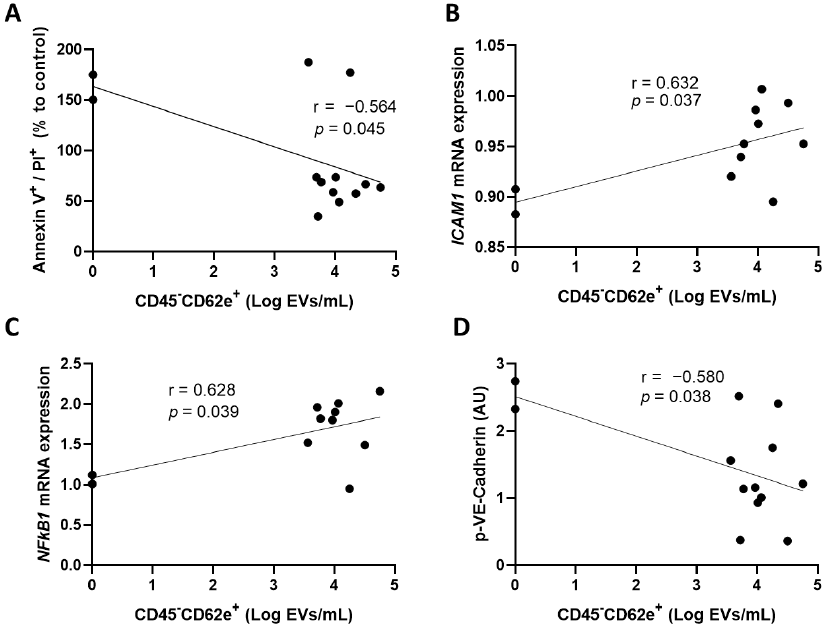
Figure 2. Circulating CD45 - CD62e + extracellular vesicles and endothelial cell activation. The correlation between CD45 - CD62e + EVs and ( A ) endothelial cells undergoing late apoptosis and necrosis, ( B ) endothelial cell ICAM1 mRNA expression, ( C ) endothelial cell NFκB1 mRNA expression; ( C ) and ( D ) phosphorylated VE-Cadherin protein expression was assessed. Data are represented as a relative percentage to cells treated with control, uninfected plasma. Significance was determined by Pearson correlation. p ≤ 0.05 was considered significant. PI: propidium iodide; EVs: extracellular vesicles; AU: arbitrary units.